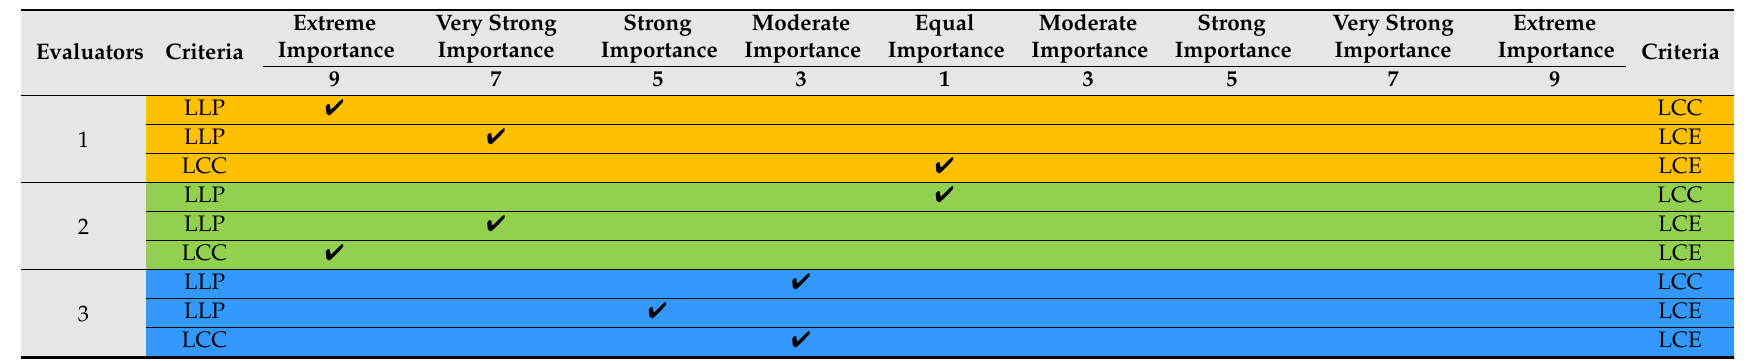
Table 4. Pairwise comparison matrix of the three criteria based on Saaty’s scale.